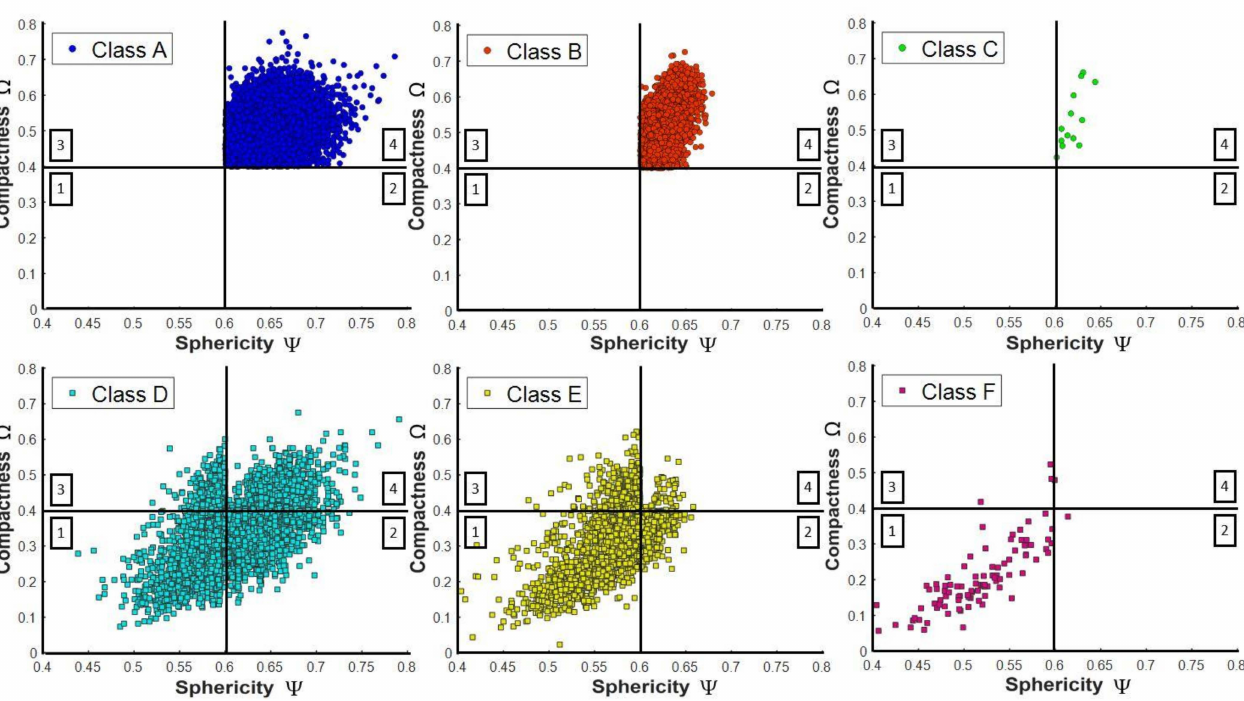
Figure 6. Pore classification of a scanned cylindrical specimen fabricated by laser powder bed fusion (details in Section 2.1). Each pore class is shown separately. The corresponding classification areas 1, 2, 3, and 4 are according to the sphericity and compactness criteria of Table